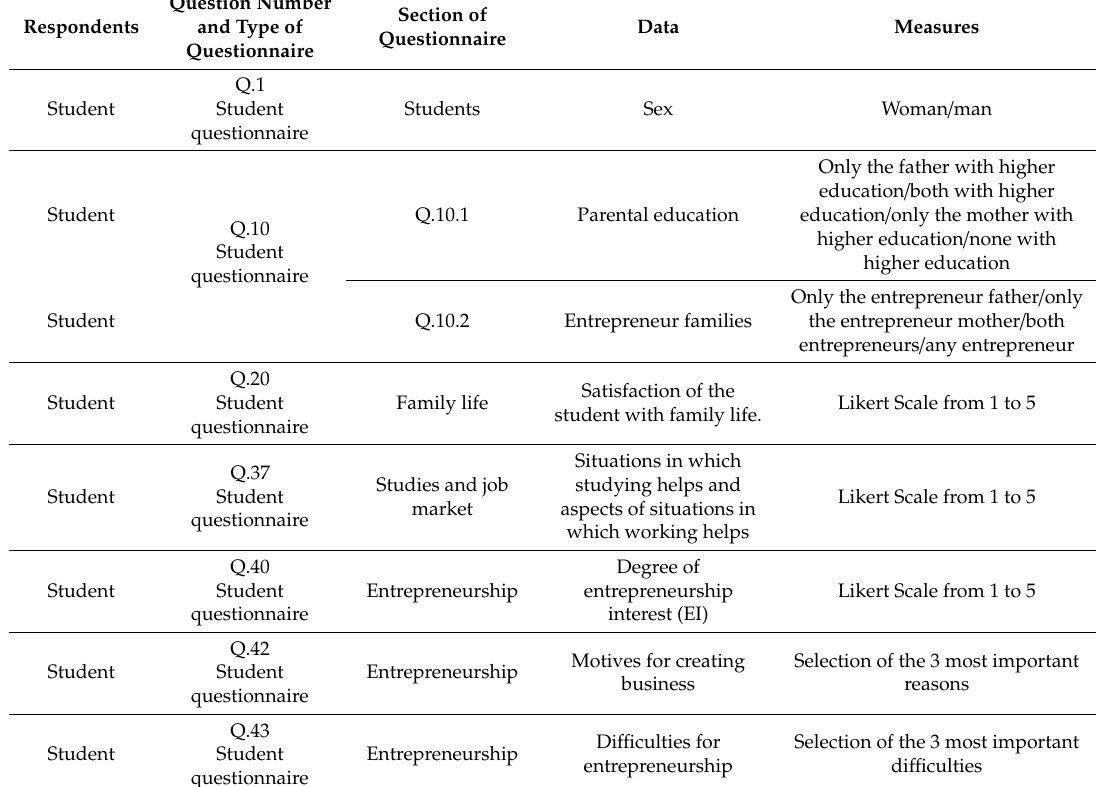
Table 1. Selection of questions / variables from the student questionnaire and the family